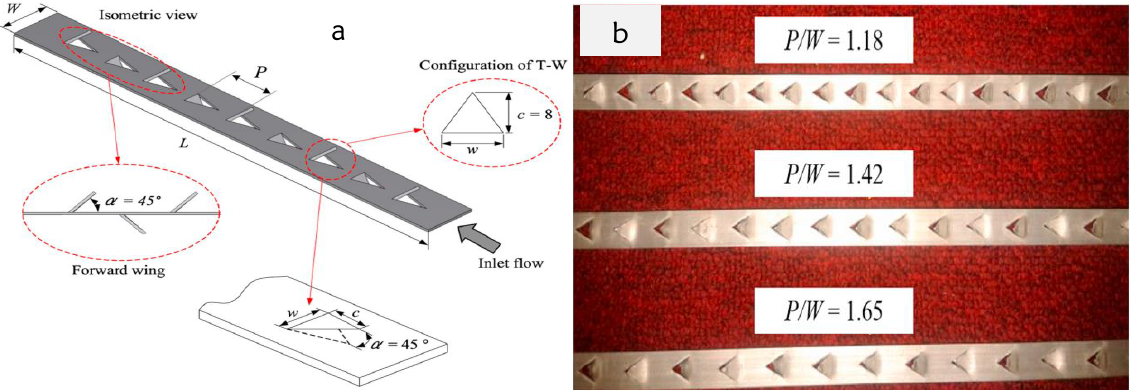
Figure 7: (a) Geometry of the delta wing tape inserts (b) photographs of delta-wing tape inserts [15].